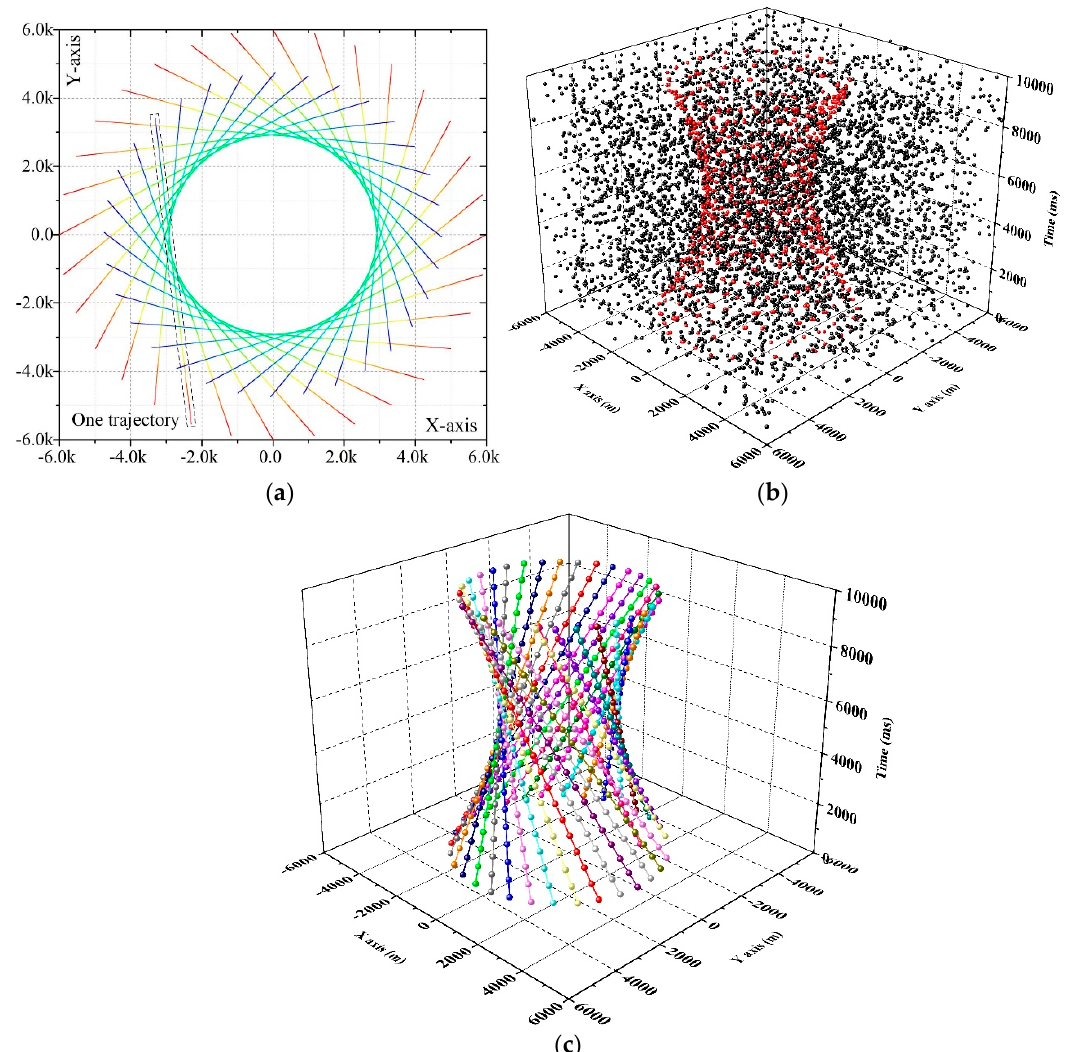
Figure 3. ( a ) The 32 true trajectories in the simulation. ( b ) The simulated measurements of the 32 true trajectories. ( c ) The result of the 3DHT-ET-TBD when the measurements in Figure 3b are taken as the input.